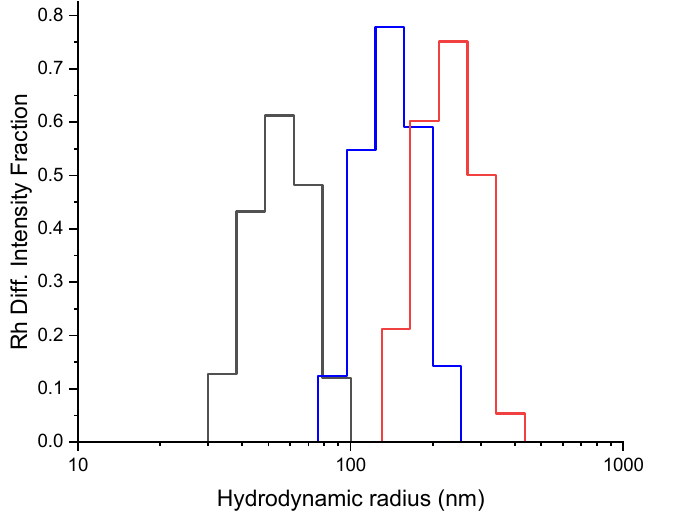
Figure 7. DLS measurements on PVA (black line), PVA@Rhod (blue line), and PVA@RhodFR (red line) aqueous solutions (0.1 g/L).